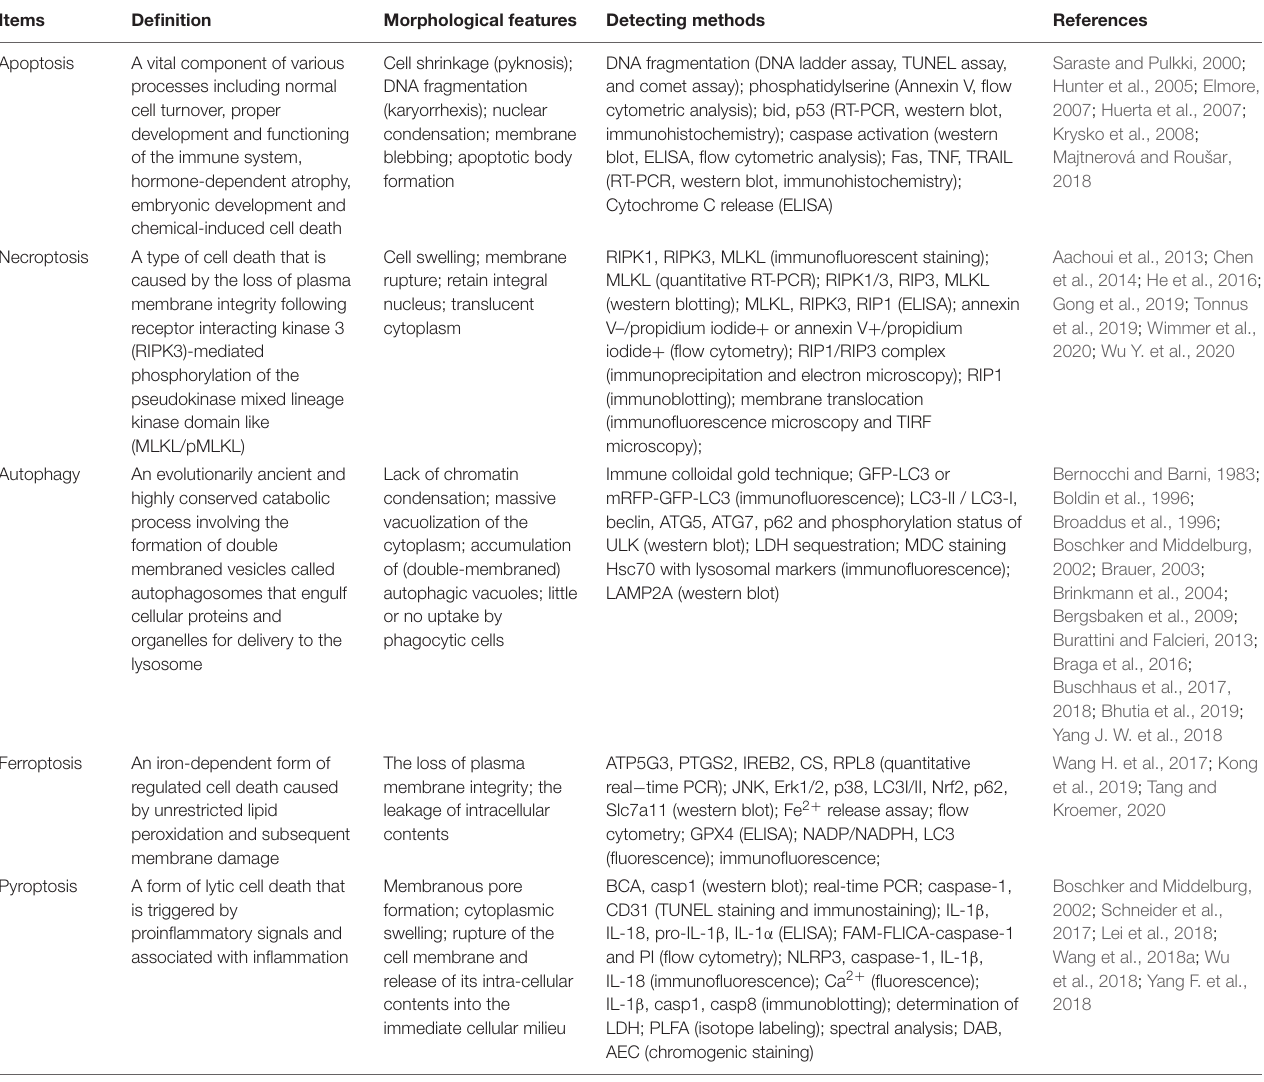
TABLE 1 | Comparison of five types of